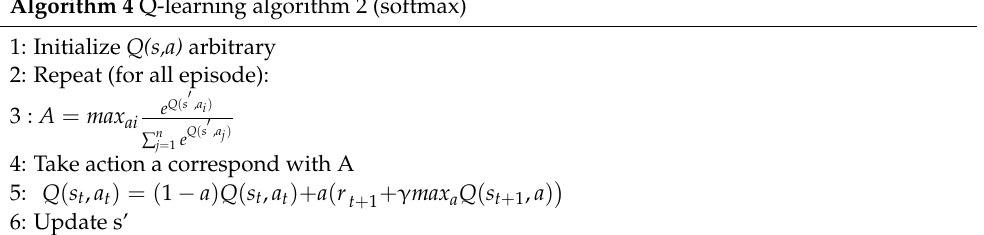
Algorithm 4 Q-learning algorithm 2